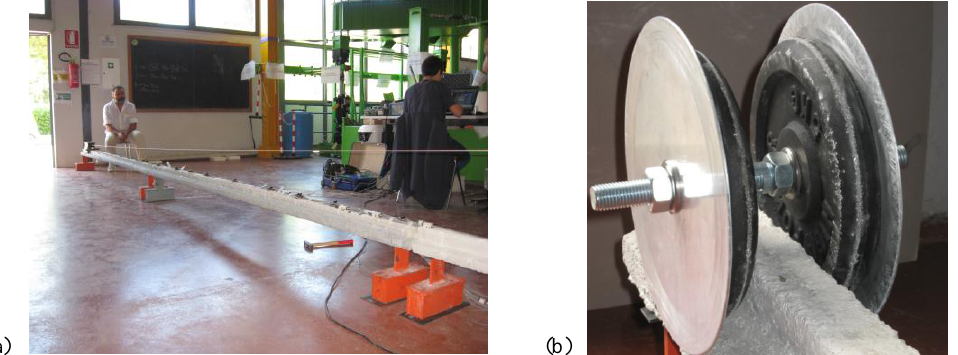
Fig. 4. The configuration test (a) and the mass crossing the beam (b).